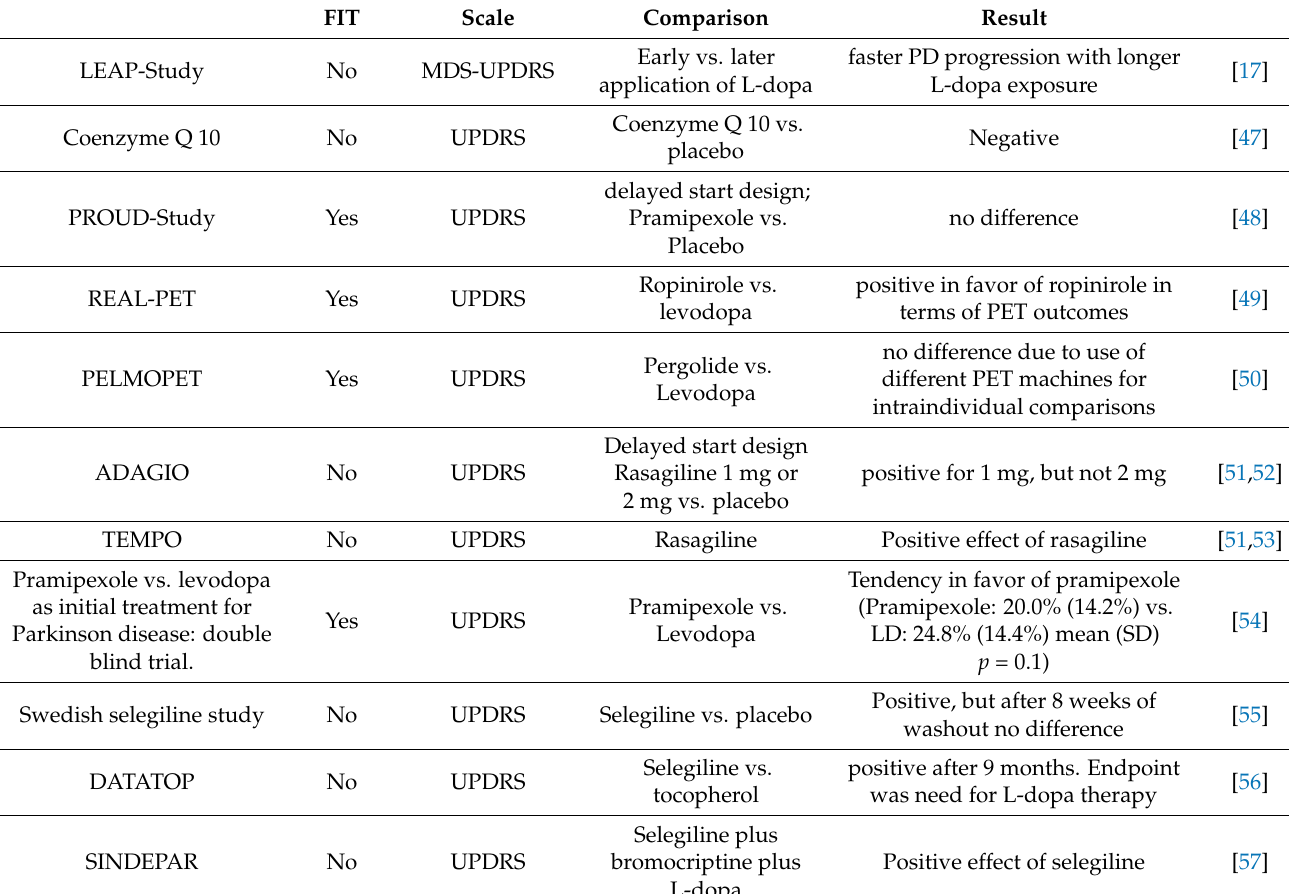
Table 2. Important trials in Parkinson’s disease, which aimed on modification of